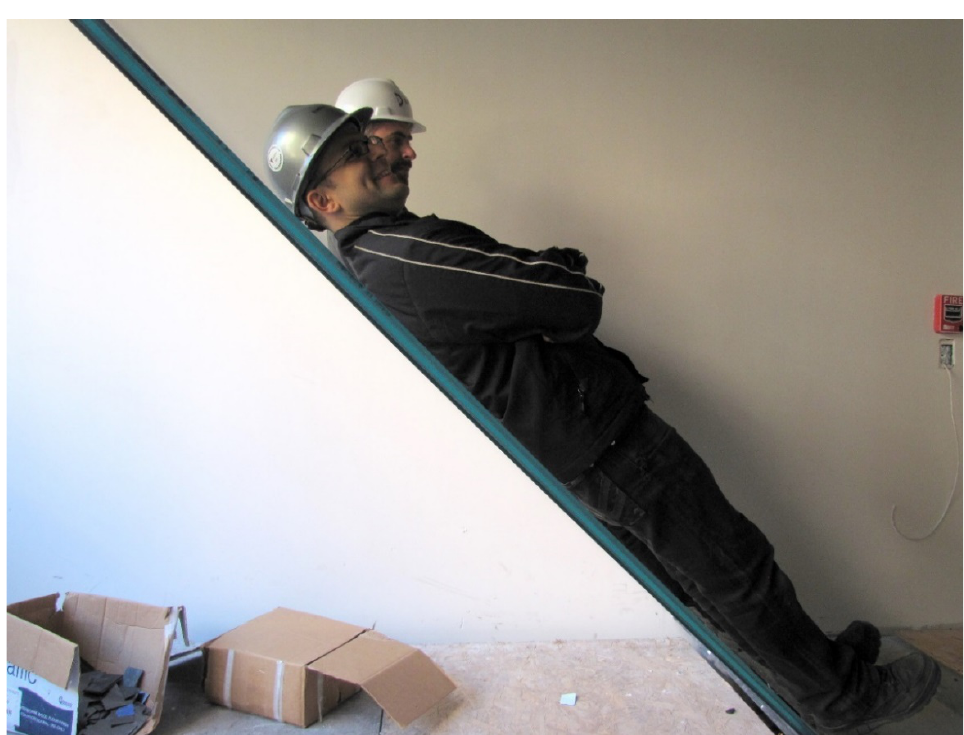
Fig. 11 P-131317, 2011 | Load testing of